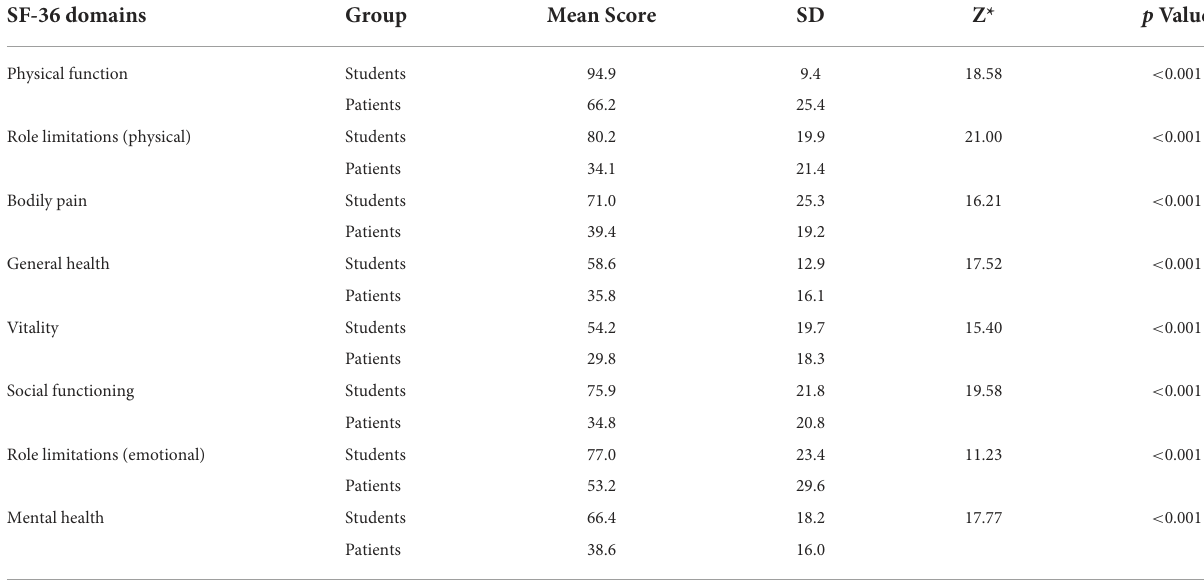
TABLE 2 Comparison between group of students and group of patients with long COVID in eight domains of the SF-36 questionnaire. SF-36